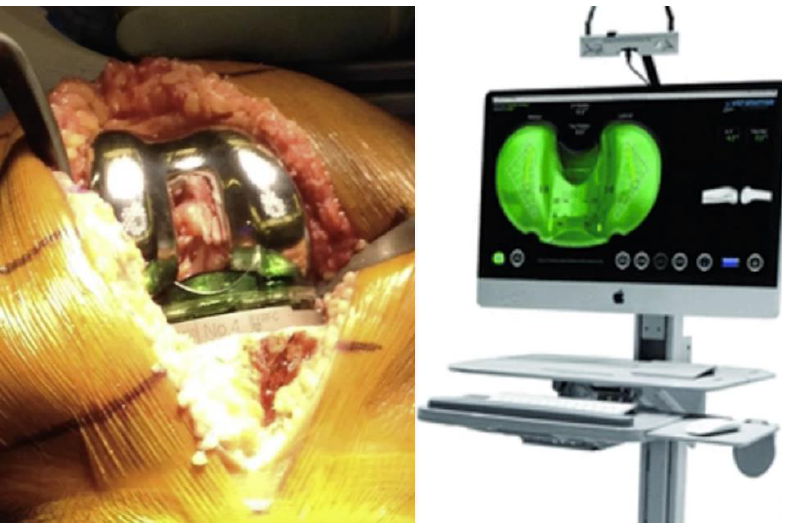
Figure 2. The sensor is an articular loading quantification device, which is inserted in the tibial component tray during the surgery, after the tibial and femoral cuts are completed (Orthosensor, Verasense).